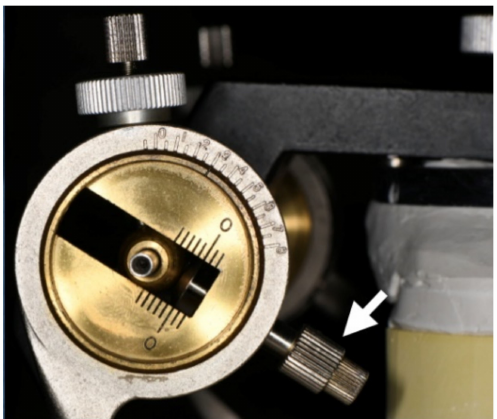
Figure 3. Please note the condylar parts of the articulator with anterior stop screws (white arrow). The articulator can be set on specific eccentric positions with the aid of these screws, making the clinical remount procedure easier to